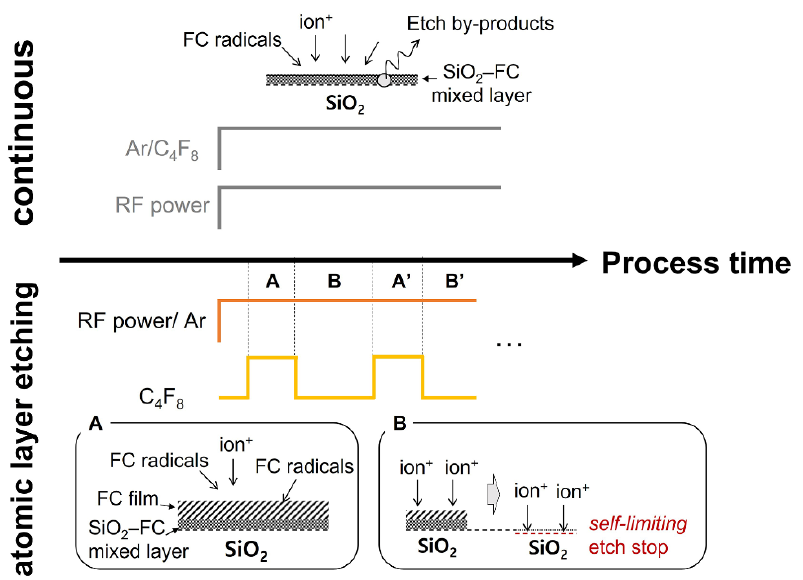
Figure 1. Comparison between continuous etching and ALE.